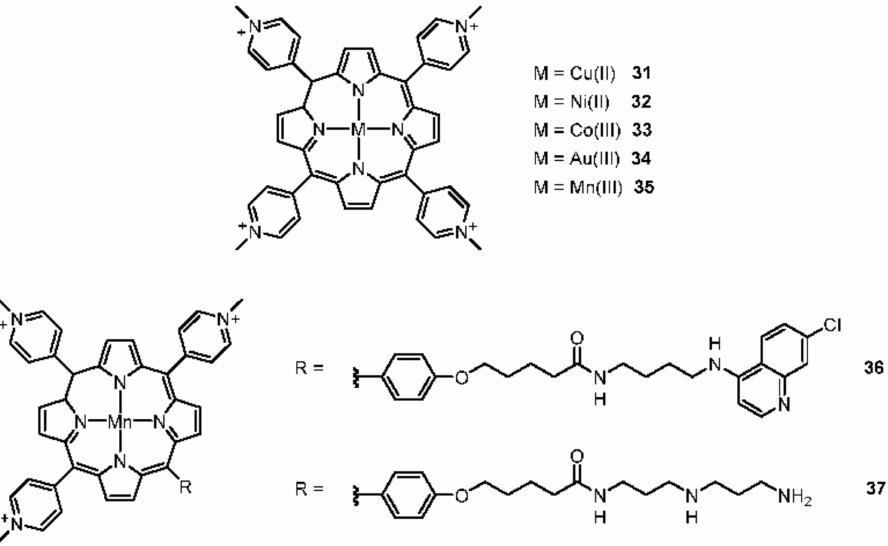
Figure 9. Structure of porphyrin ligands used with various metal ions for G-quadruplexes recognition.